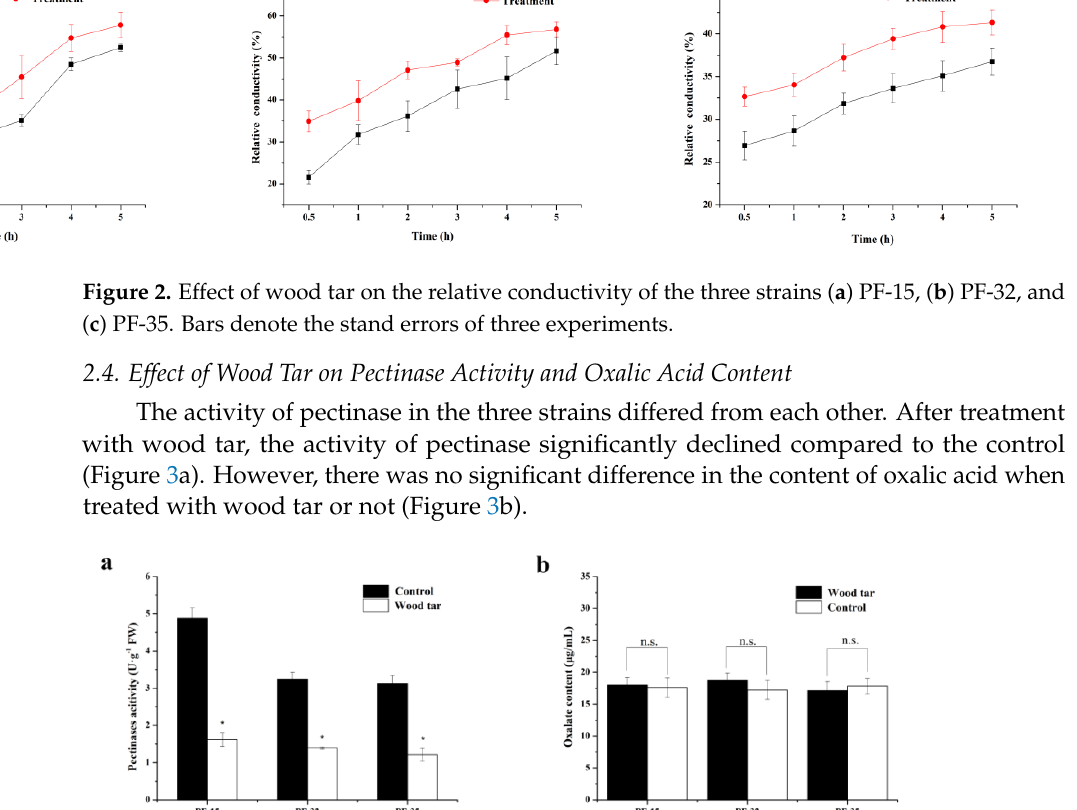
Figure 3. Effect of wood tar on the pectinase activity ( a ) and oxalic acid content ( b ). Bars denote the stand errors of three experiments. * denotes significant difference according to Fisher’s protected LSD test ( p =